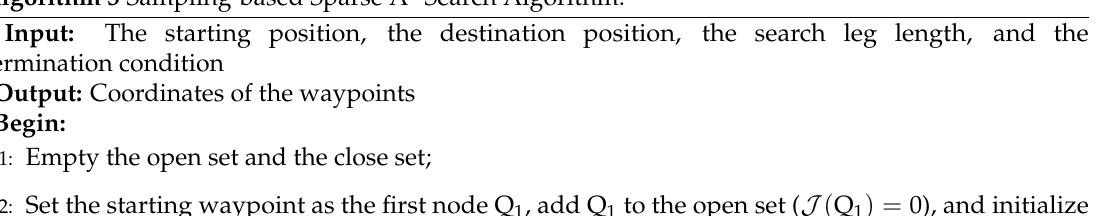
Algorithm 3 Sampling-based Sparse A* Search